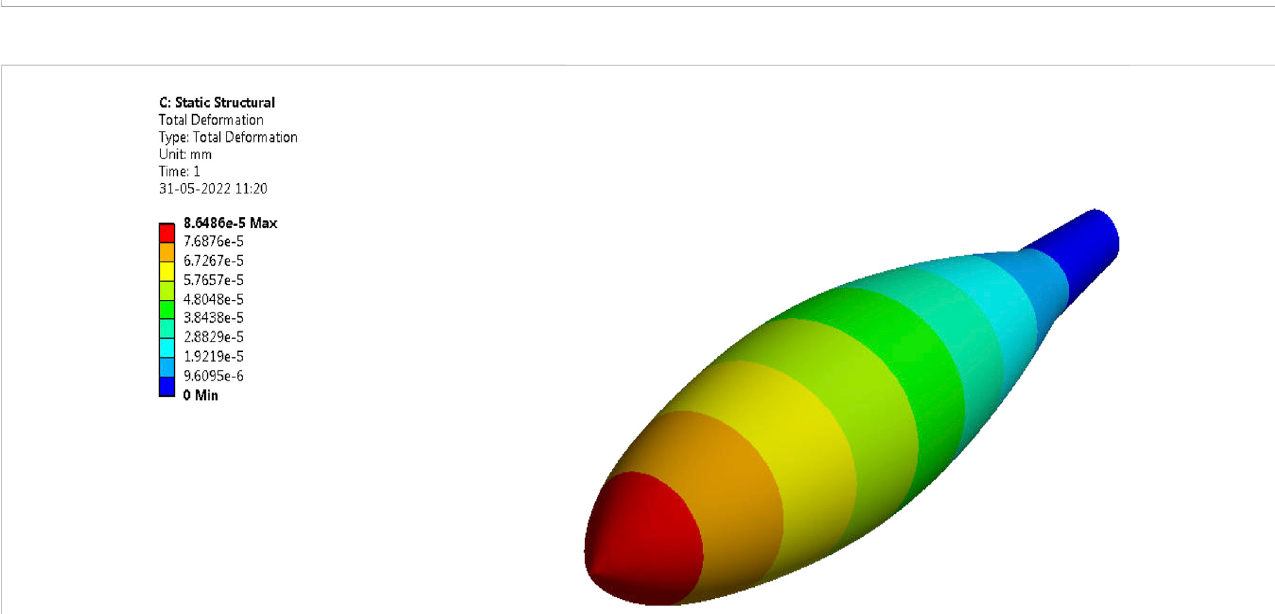
FIGURE 18 Total deformation on full fuselage of RUAV with